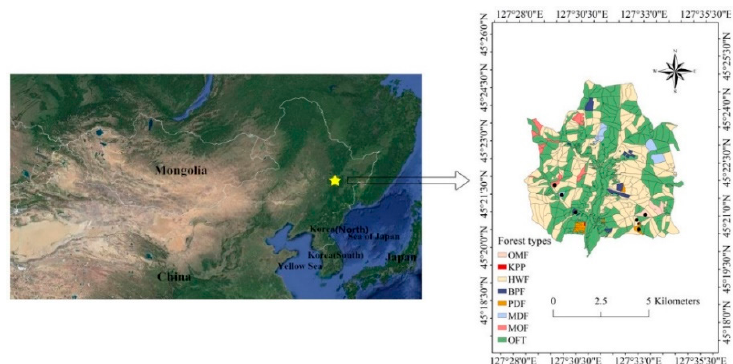
Figure 1. Map of the study site at the Maoershan Ecosystem Research Station of Northeast Forestry University in Northeast China (right map). The study site is located at the yellow pentacle of the left map. Seven black dots in the right map represent sampling sites of seven forest types. Abbreviation: OFT: other forest types (outside the seven forest types in present paper).